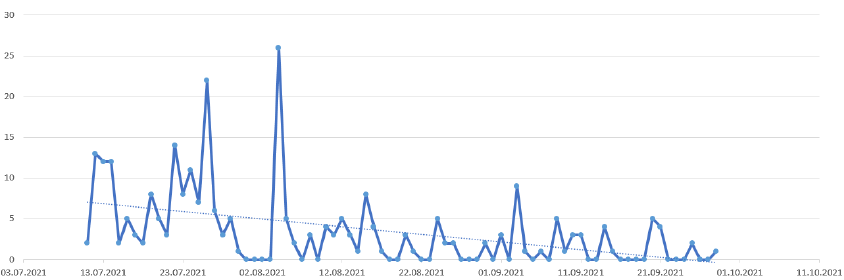
Figure 15. Number of messages without an answer from the chatbot or